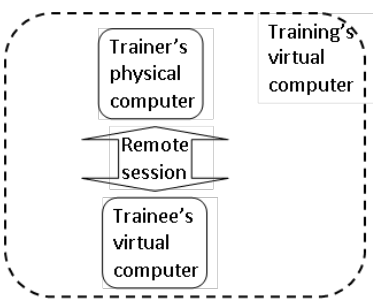
Fig. 5. Topology of training session virtual computer after interception of trainee’s remote session on the server by the trainer.